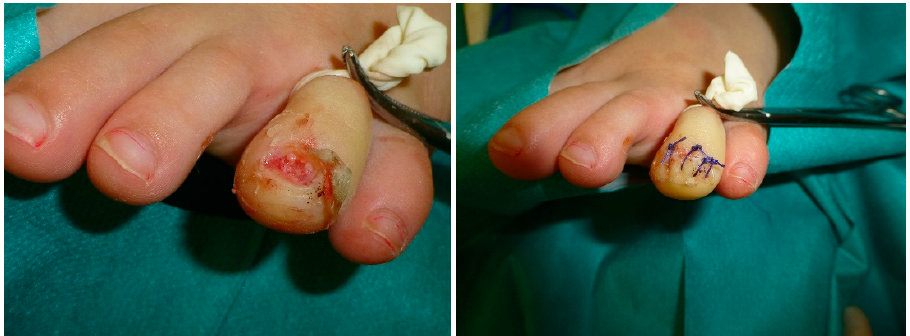
Figure 3. Curettage and removed subungual mass. Destruction of the nail bed after completion of the excision and curettage of the lesion. The nail plate was then debrided of all peripheral tissue and cleansed. The nail plate was sutured back into place, proximally and distally.